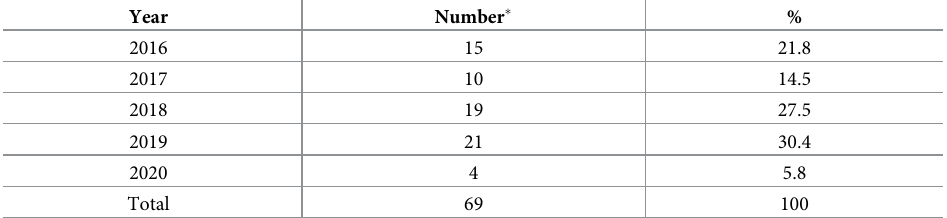
Table 2. Distribution of the partnerships signed between agricultural cooperatives and other actors based on the investigation period.